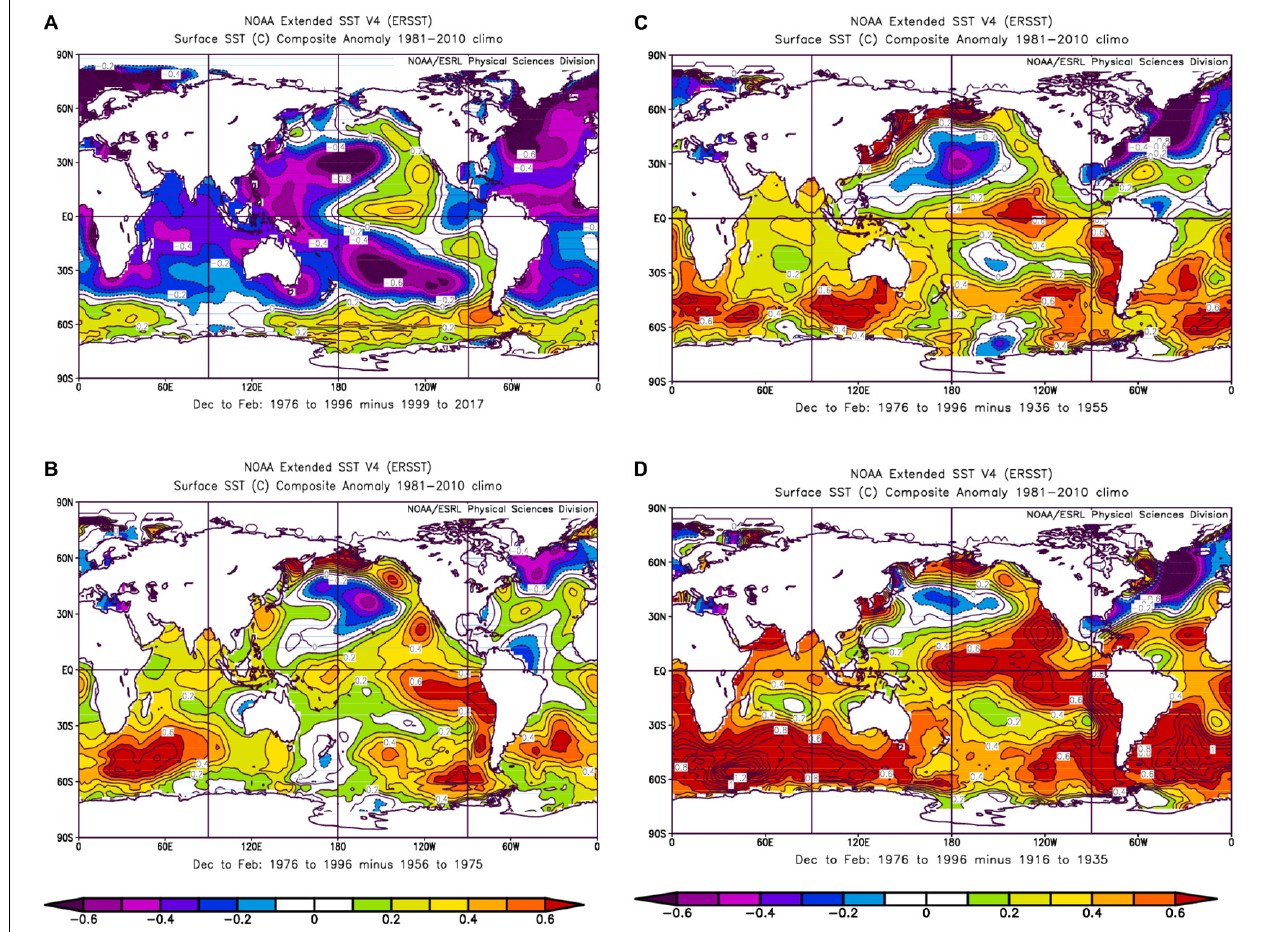
FIGURE 2 | SST anomaly (DJF) from NOAA Extended SST V4 (ERSST), for 1976–1996 with respect to different reference levels: (A) 1999–2017, (B) 1956–1975, (C) 1936–1955, and (D) 1916–1935, respectively. Plots are generated from the NOAA/ESRL Physical Sciences Division, Boulder Colorado web site at